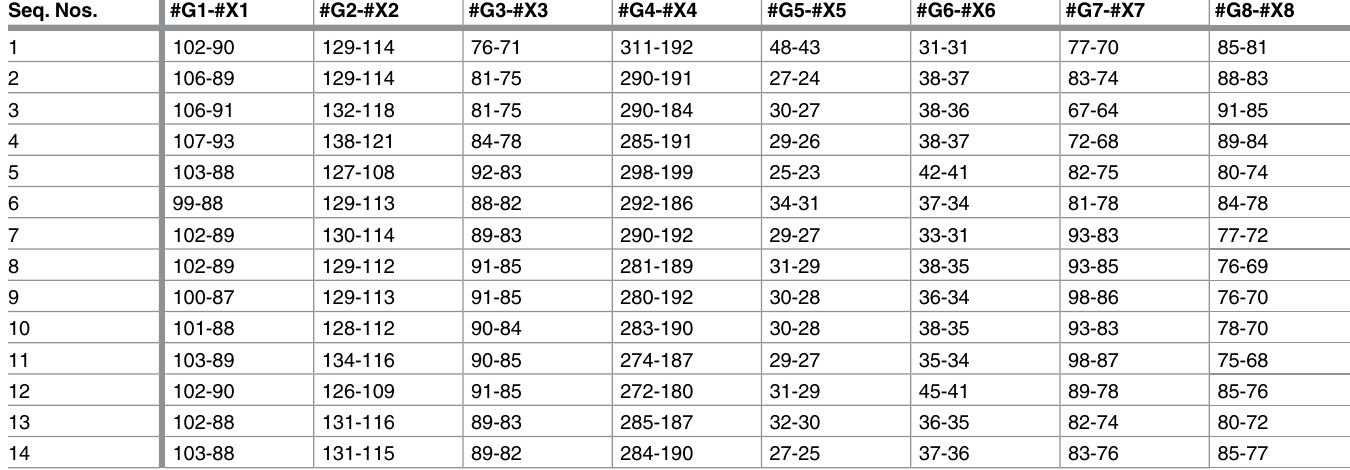
Table 11. List the total number of amino acids from a particular chemical group followed by the order pairs count except self order pair for each sequence of myosin head domain. Seq. Nos.